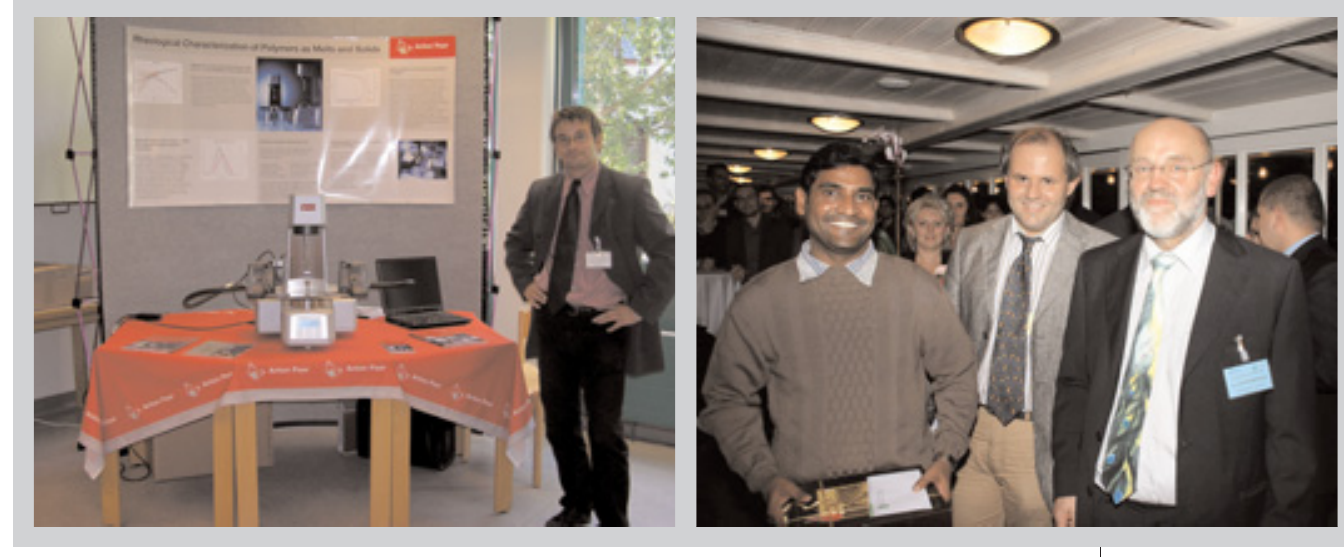
Figure 1 (left): New equipment was pre- sented by a number of companies, of course also by the Austrian supplier Anton Paar KG. Figure 2: The main organizers, Prof. Schausberger (right) and Dr. Gahleitner (center) handing over the best poster award to Rajendar